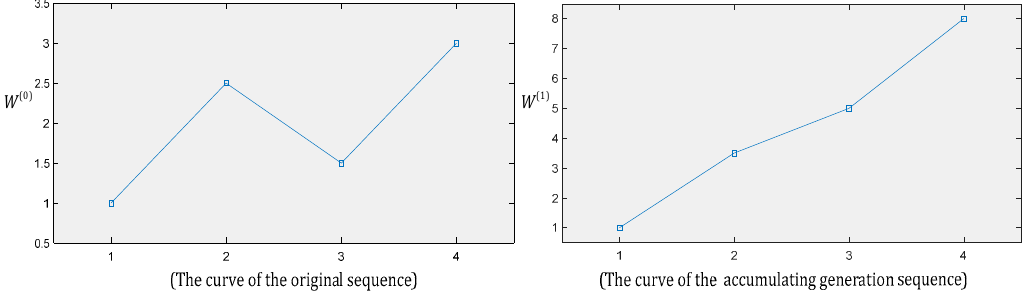
Figure 1. Curves with the raw sequence and its accumulating generation sequence Accumulating generation operation (AGO) is a method employed to whitenize a grey process.